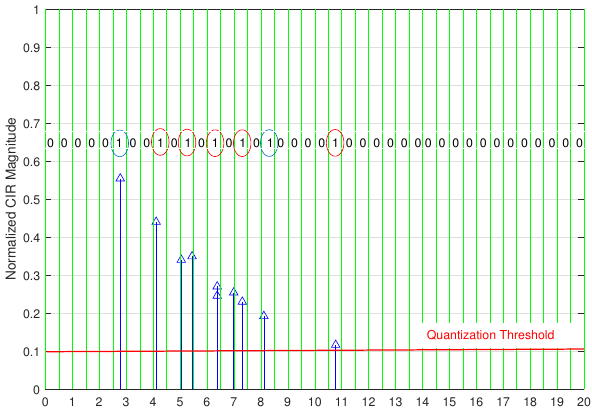
Figure 10. CIR of Scenario 3.